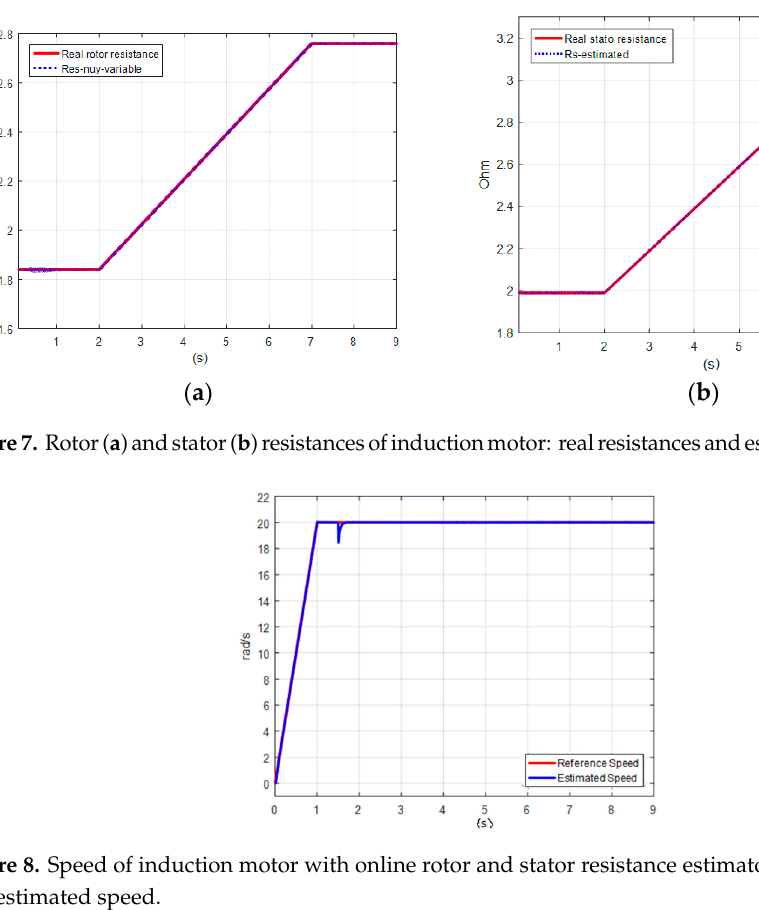
Figure 8. Speed of induction motor with online rotor and stator resistance estimators: reference speed and estimated speed.